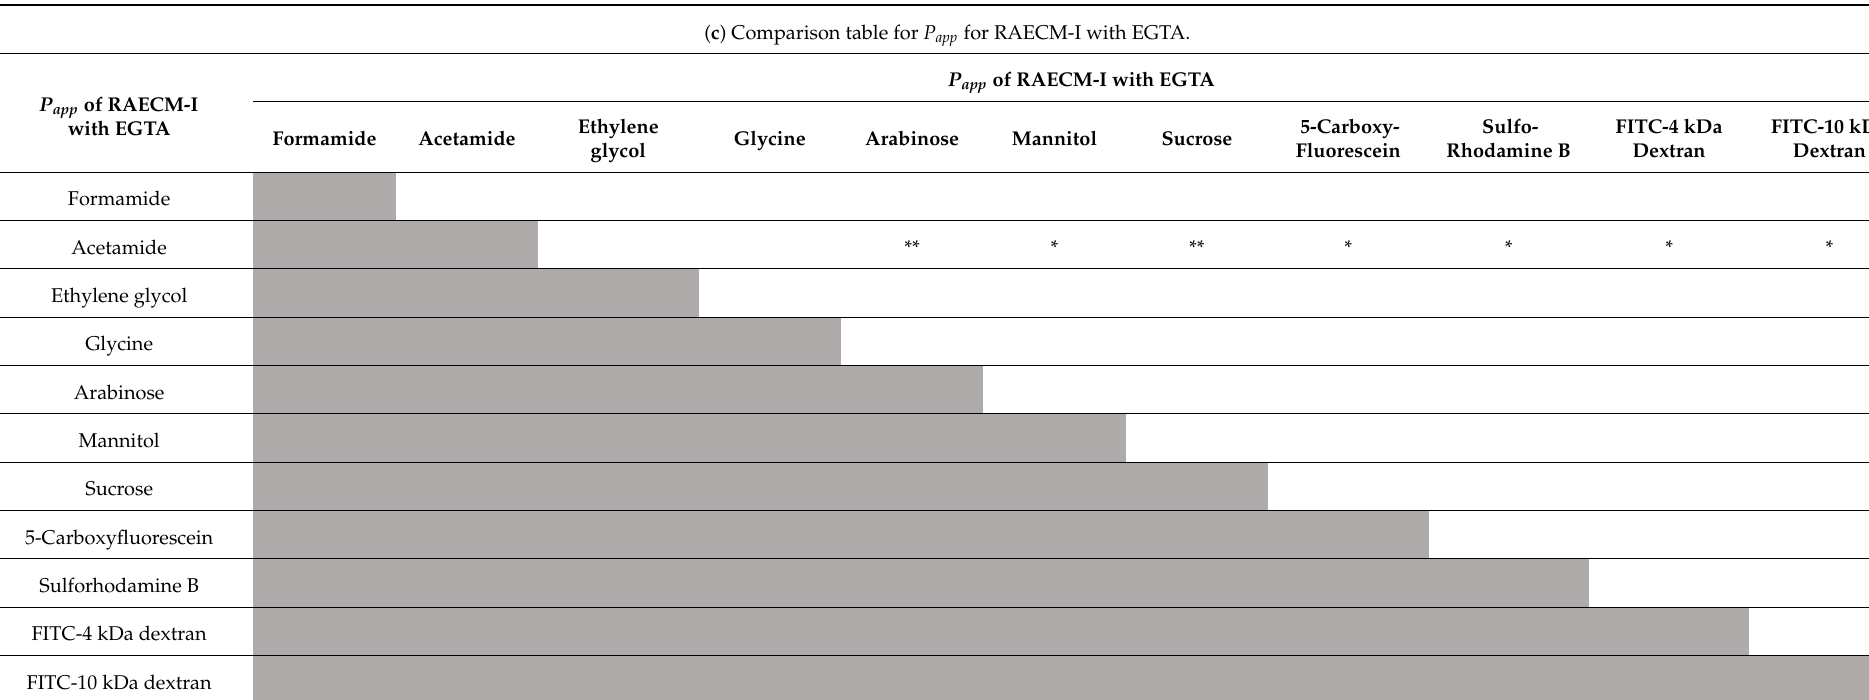
Table A1. Cont. ( c ) Comparison table for P app for RAECM-I with